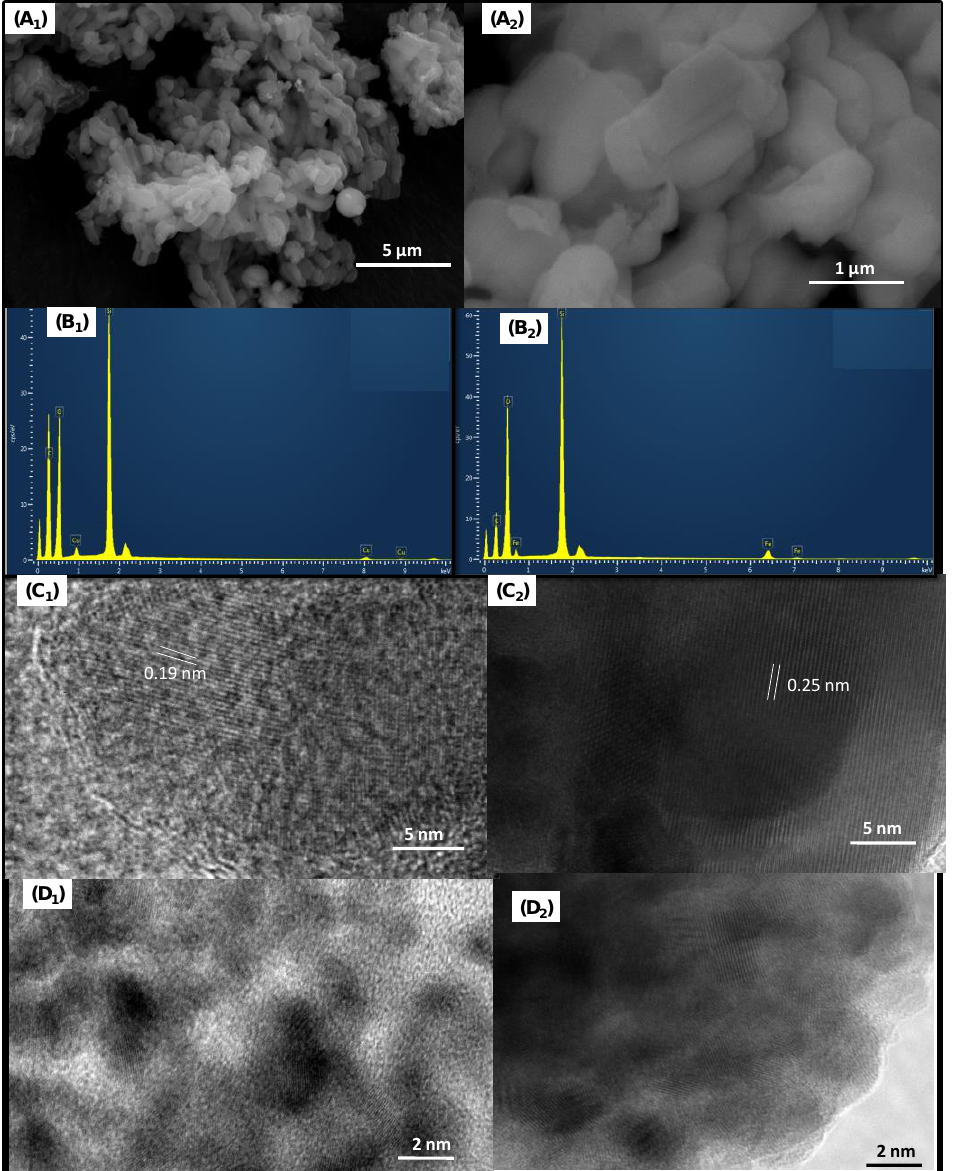
Figure 2. ( A ) SEM micrographs, ( B ) EDS spectra, ( C ) TEM and ( D ) HRTEM micrographs of the samples. The indices 1 and 2 below the letters indicate Cu 8 /SBA-15 and Fe 10 /SBA-15 samples, re- spectively.